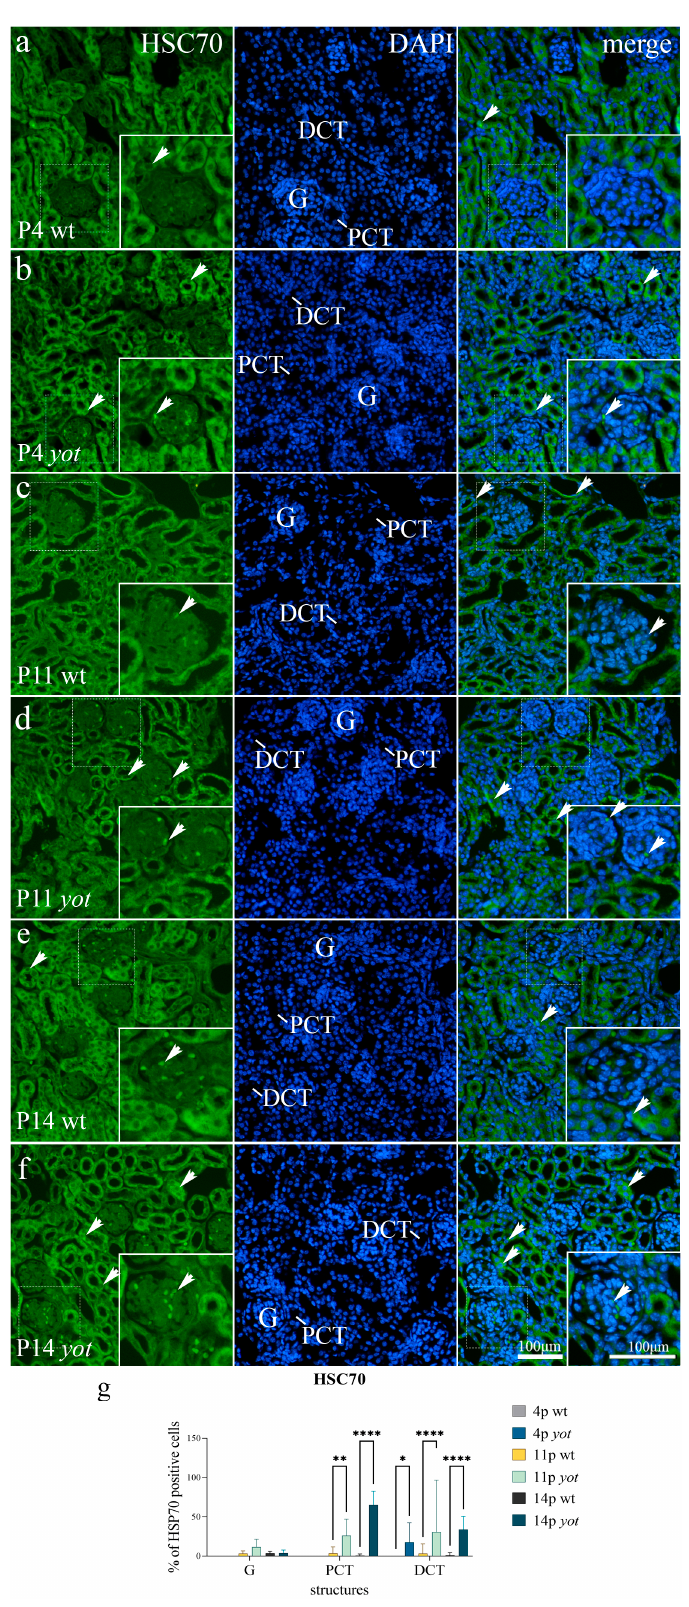
Figure 6. Immunofluorescence staining of postnatal wild-type (wt) ( a , c , e ) and yotari ( b , d , f ) mouse kidneys with HSC70 marker and DAPI nuclear staining. Three mice were used for each genotype ( yotari and wt) at every observed time point. Arrows show the expression pattern of HSC70 in glomeruli